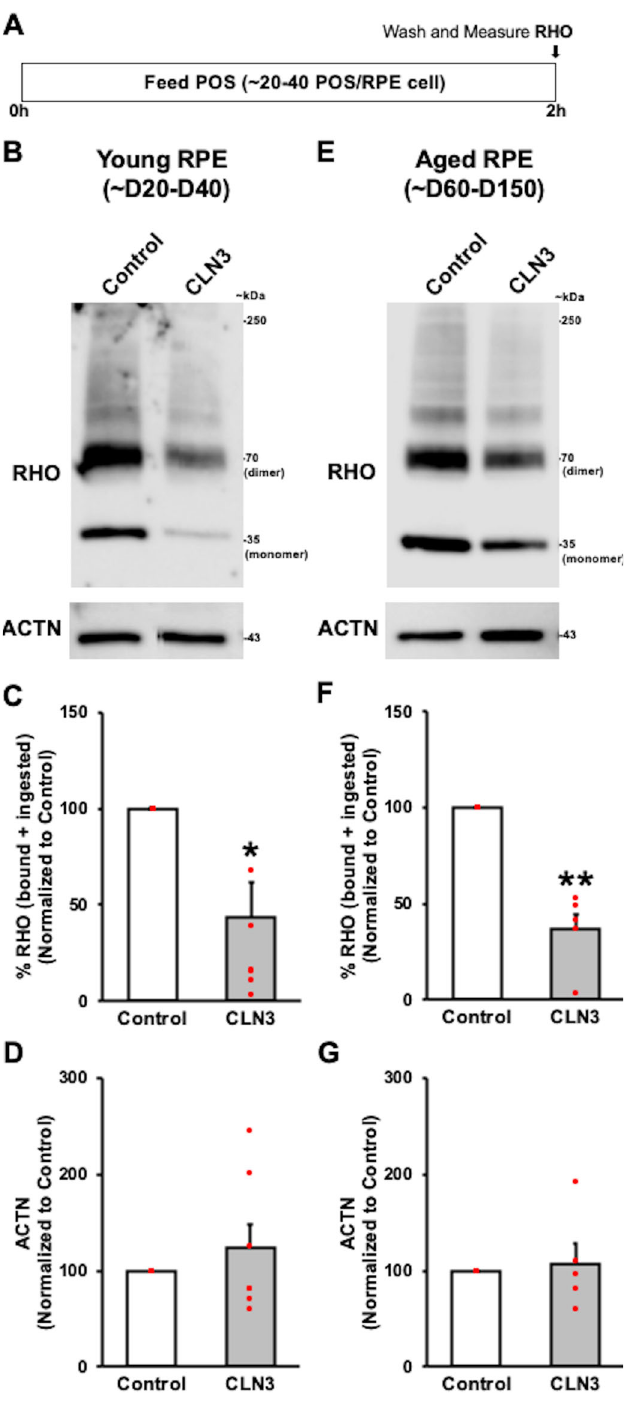
disease hiPSC-RPE cells (Fig. 8E, G). Overall, these experi- ments suggest CLN3 loss of function in CLN3 disease hiPSC- RPE cells and demonstrate a rescue of POS phagocytosis defect by lentiviral-mediated expression of WT-CLN3 in CLN3 dis- ease hiPSC-RPE cells.